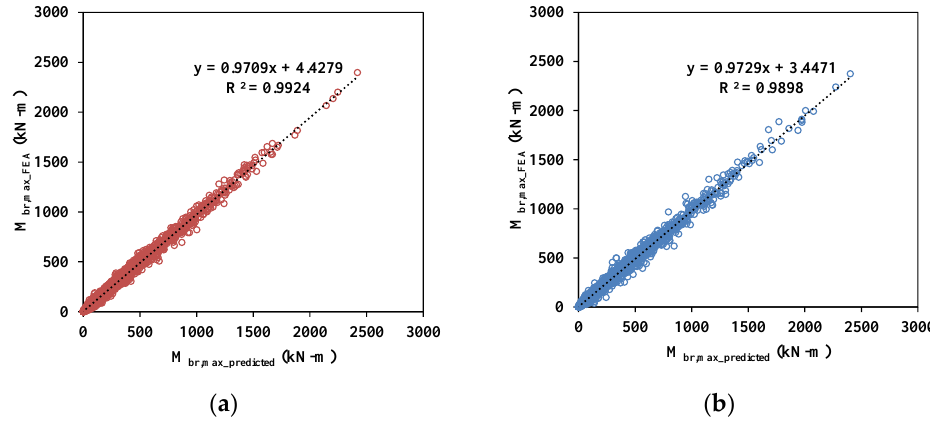
Figure 11. Comparisons of predicted minimum bracing moments ( 𝑀 𝑏𝑟,𝑚𝑖𝑛 ) of training and validation data sets: ( a ) training data and ( b ) test data.